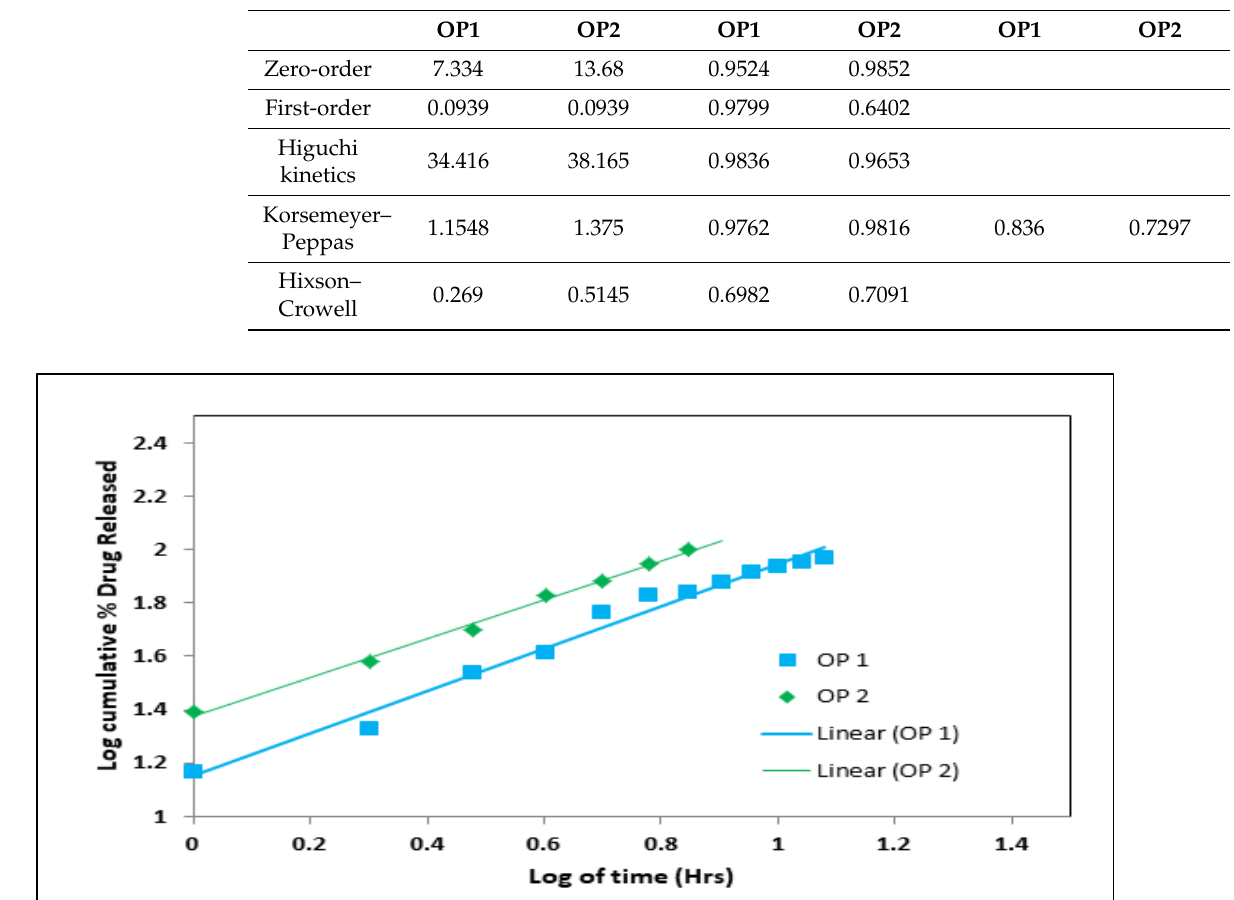
Table 9. In vitro release profile of optimized formulation (OP1 and OP2) in various models.